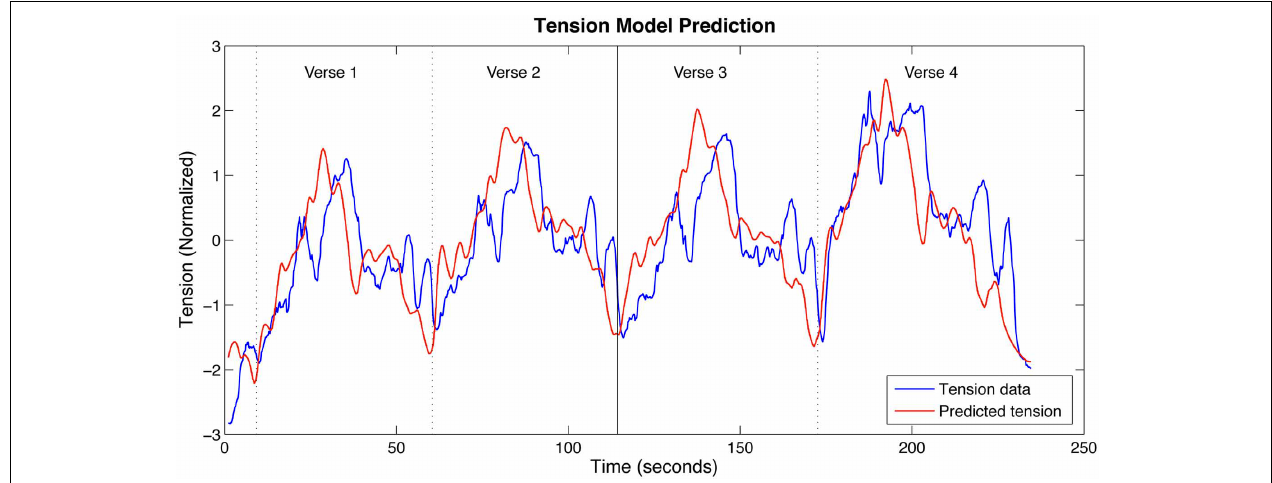
FIGURE 4 | Trend salience model predictions and the mean tension response. The solid vertical line indicates the boundary between Verses 2 and 3, the division between the training data (left side) and the test data (right side). The vertical dotted lines mark the other verse boundaries.